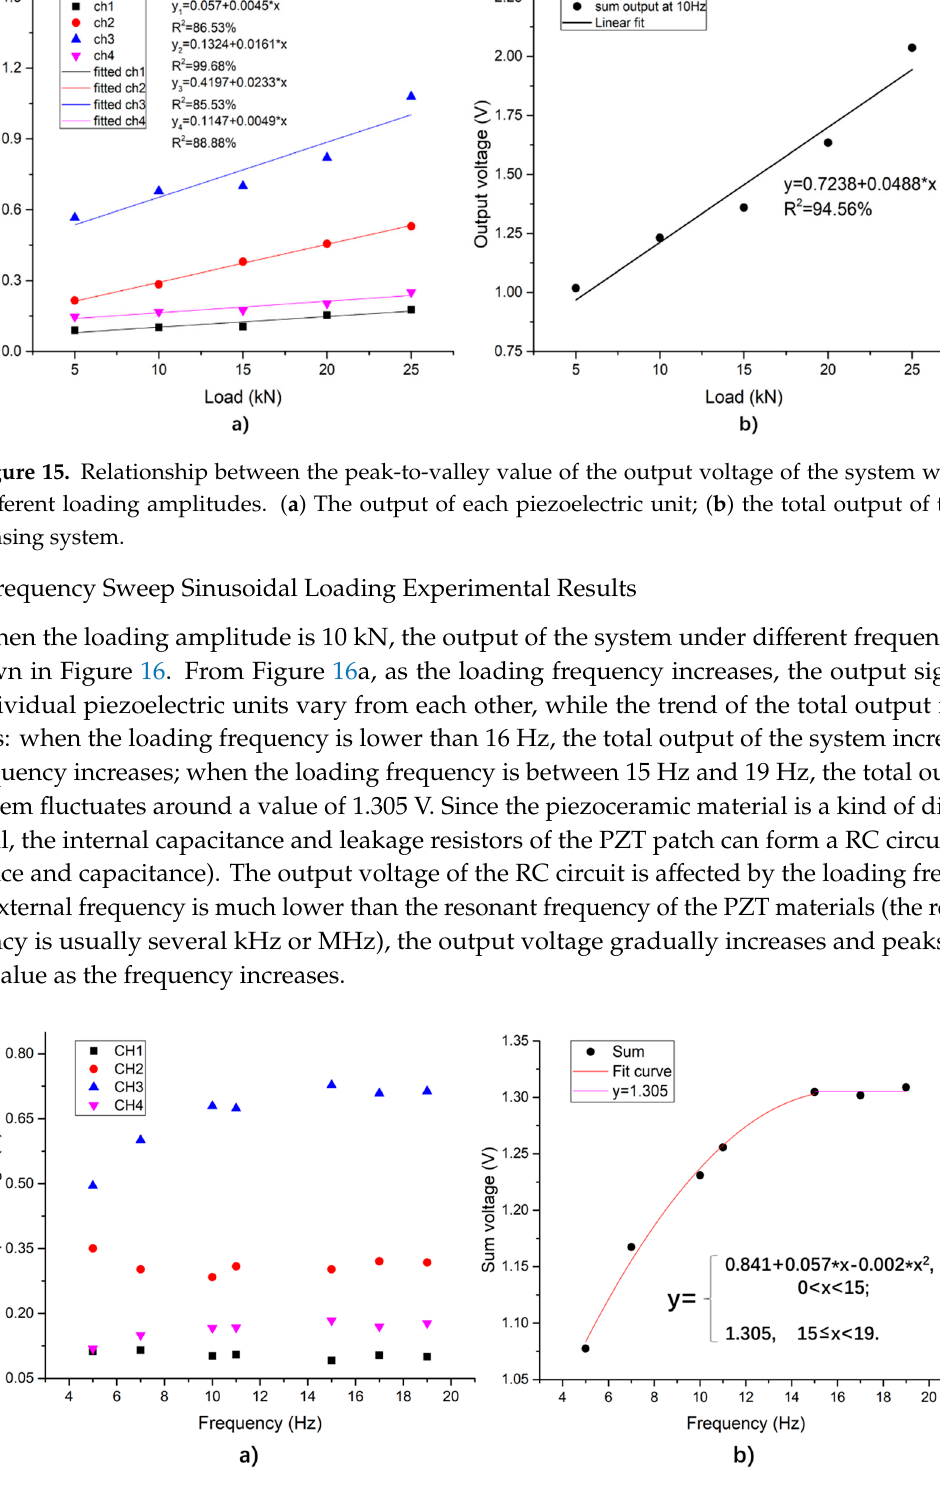
Figure 16. Output voltage peak-to-valley value vs. load frequency when loading amplitude is 10 kN. ( a ) Output of each piezoelectric unit; ( b ) piezoelectric sensing system total output.